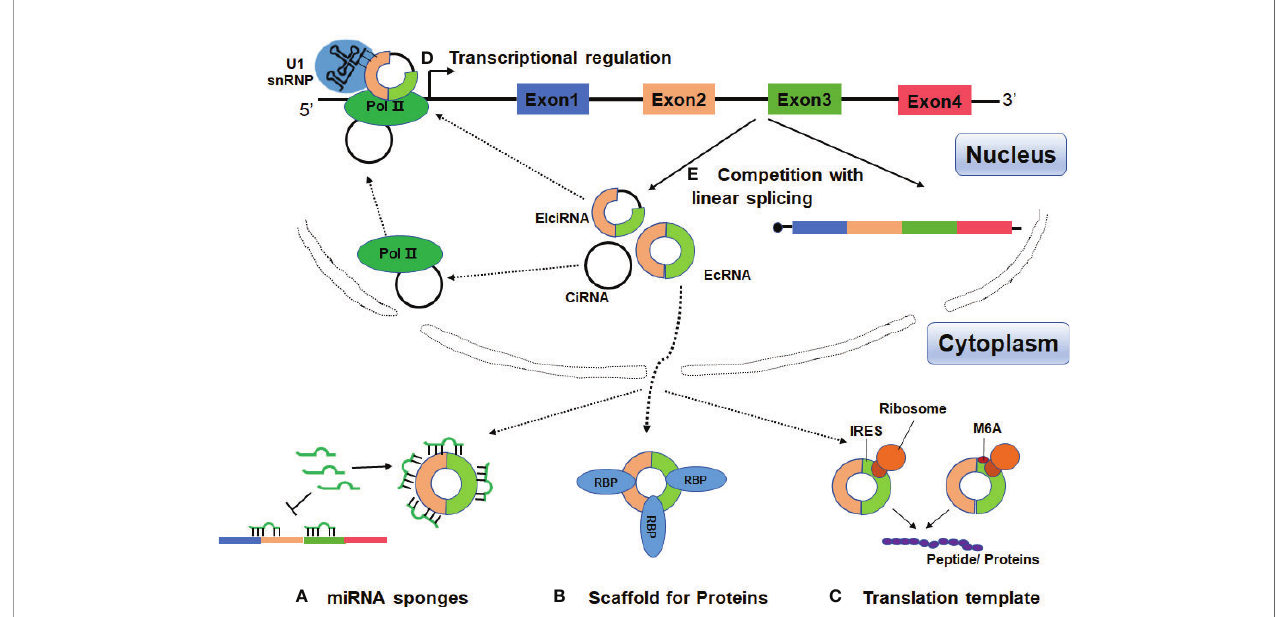
FIGURE 2 | Functions of circRNAs. (A) CircRNAs can act as miRNA sponges to diminish the effects of miRNAs on target mRNAs. (B) CircRNAs can serve as scaffolds or decoys for RBPs to modulate their functions, thus affecting the related biological processes. (C) CircRNAs may be translated if they contain an internal ribosome entry site (IRES) or extensive N6-methyladenosines (m6A) modi fi cation. (D) CircRNAs can promote transcription by interacting with U1 small nuclear ribonucleoprotein (U1 snRNP) and the RNA polymerase II (Pol II) in the nucleus. (E) The processing of circRNAs could affect host gene expression by competing with their linear mRNA